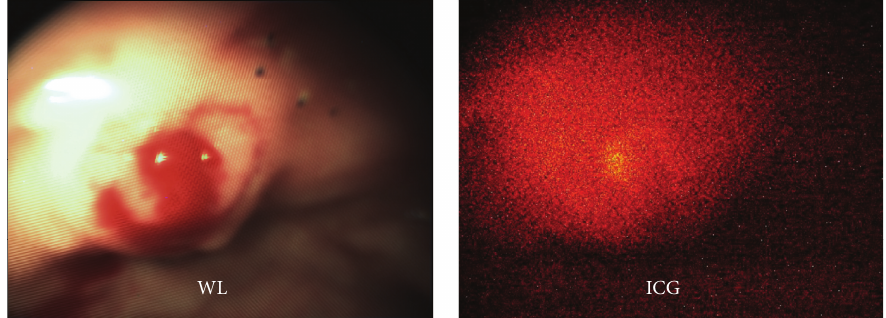
Figure 3: Patient 2 fluorescence endoscopy. A 10mm tubular adenoma demonstrates slightly greater ICG uptake over background (TBR 1.21).